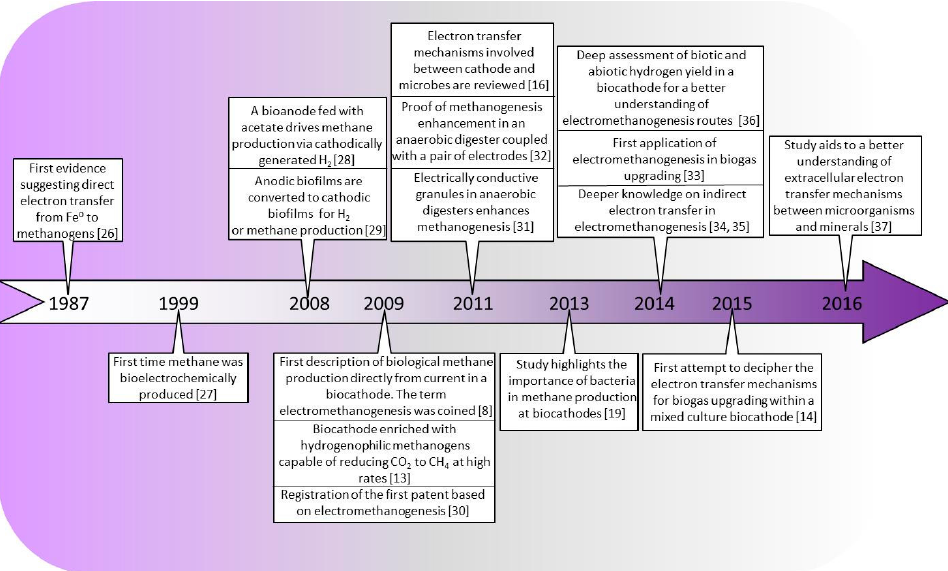
Figure 2. Historical overview of major achievements towards methane production via BESs. In 1987 Daniels et al. reported for the first time the capability of some methanogens to use elemental iron as an electron donor and reduce CO 2 into CH 4 [26]. 12 years later, in 1999 Park et al. used a BES with pure and mixed cultures of H 2 -consuming bacteria to produce methane from CO 2 [27]. They used neutral red as the sole source of reducing power, thus replacing H 2 as the sole electron donor source. In 2008, works of Clauwaert et al. and Rozendal et al. on H 2 production at the cathode [28] and the placement of cathodic biofilm for H 2 and CH 4 production [29], served as a precursor for the birth of the term [8] just one year later by Cheng et al. During the same year 2009 the first patent based on